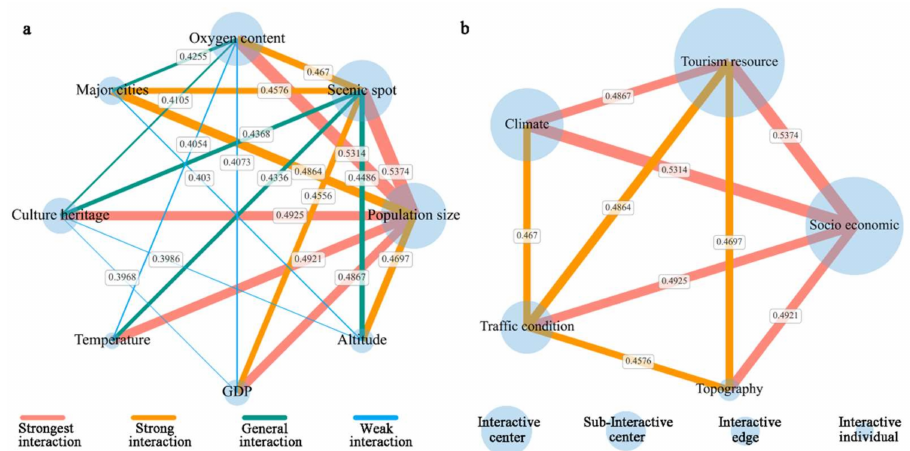
Figure 13. Diagram of interactions network: ( a ) evaluation indexes; ( b ) influencing